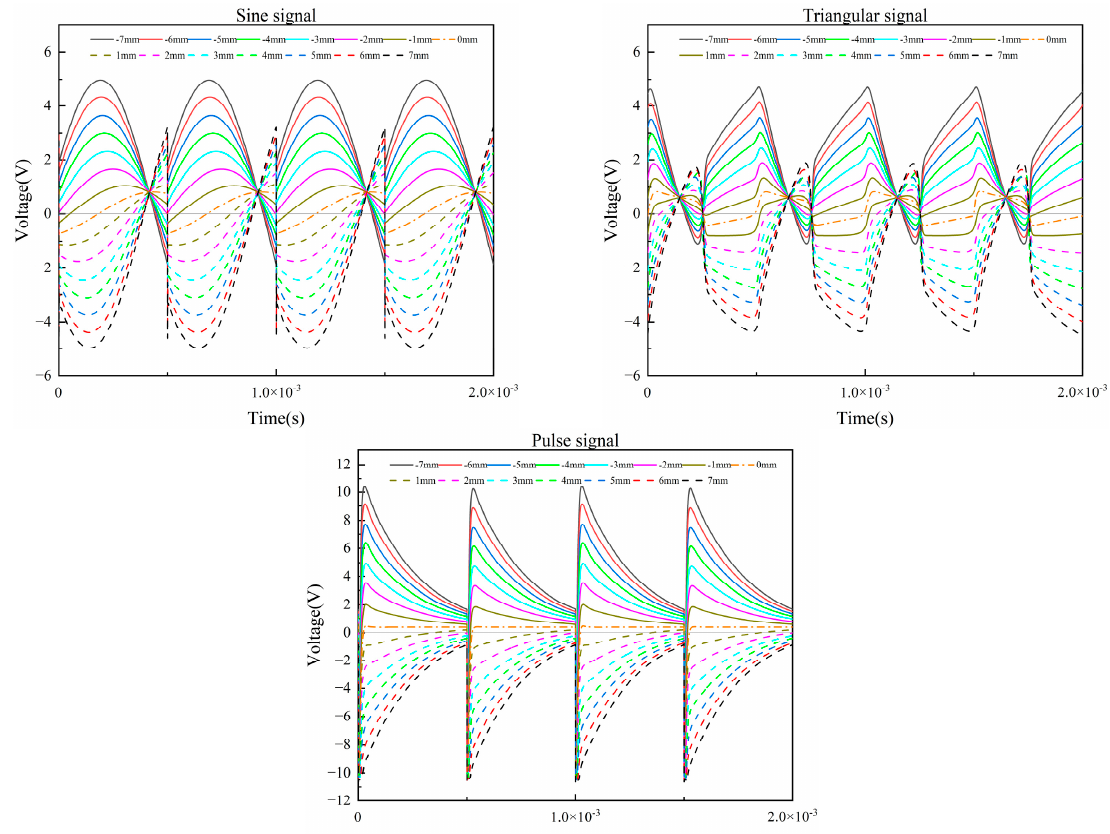
Figure 9. Output signal of the AD630 chip under three excitation signals.